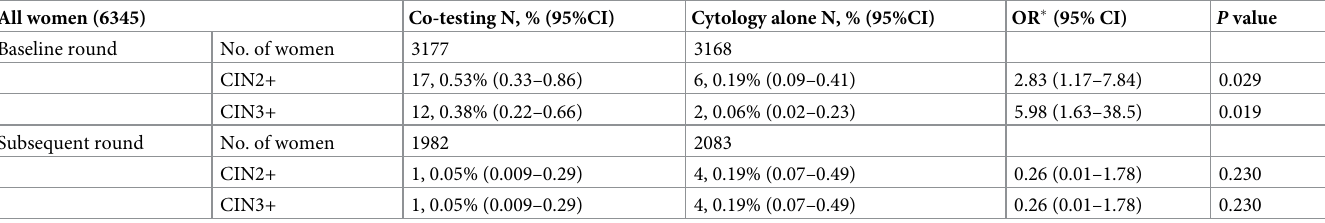
Table 6. Comparison of CIN2+ and CIN3+ detection rates in co-testing and cytology alone groups. All women